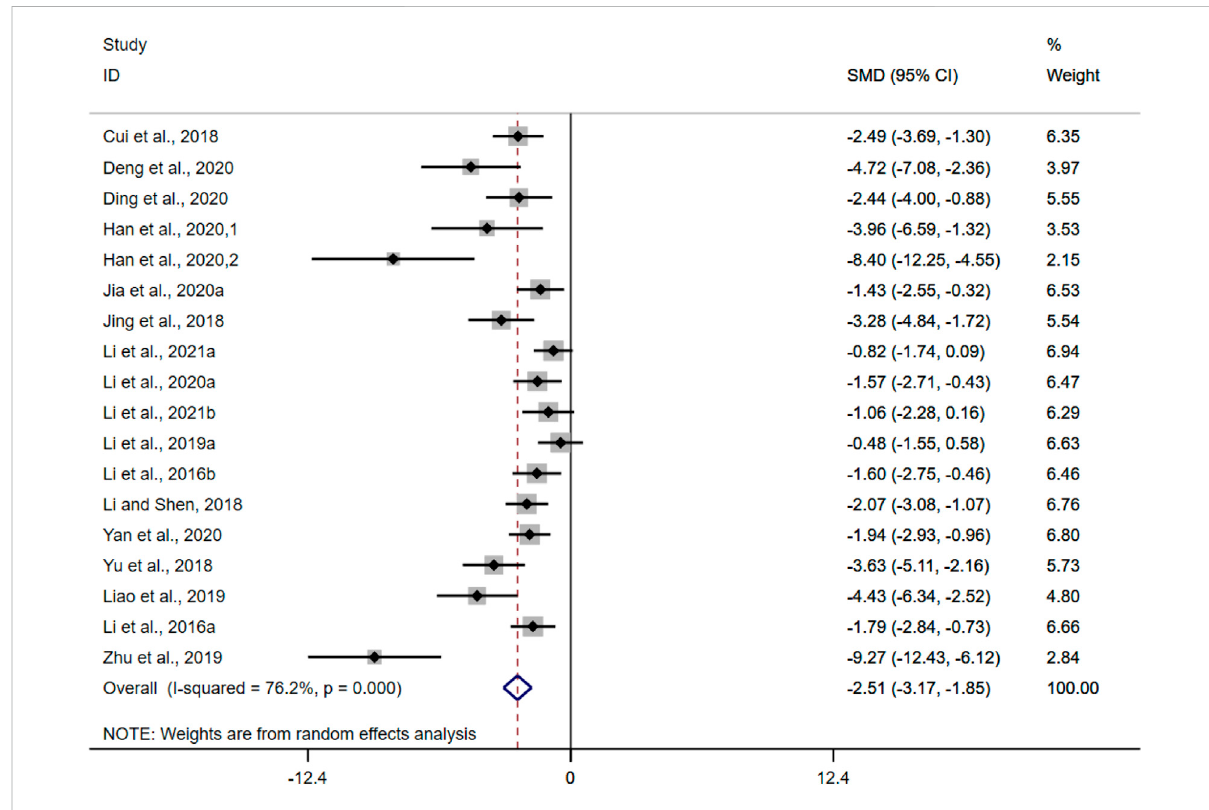
FIGURE 5 Forest plot: effect of berberine on DAI scores